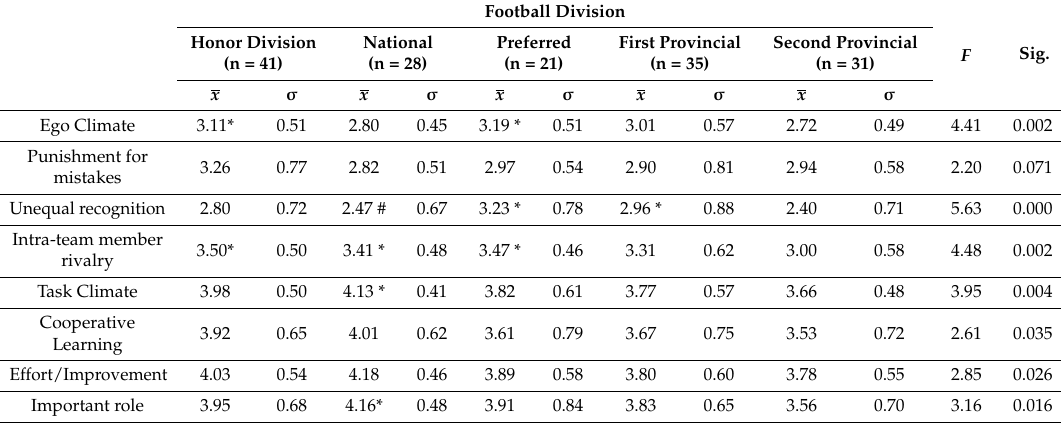
Table 2. Motivational Climate and football